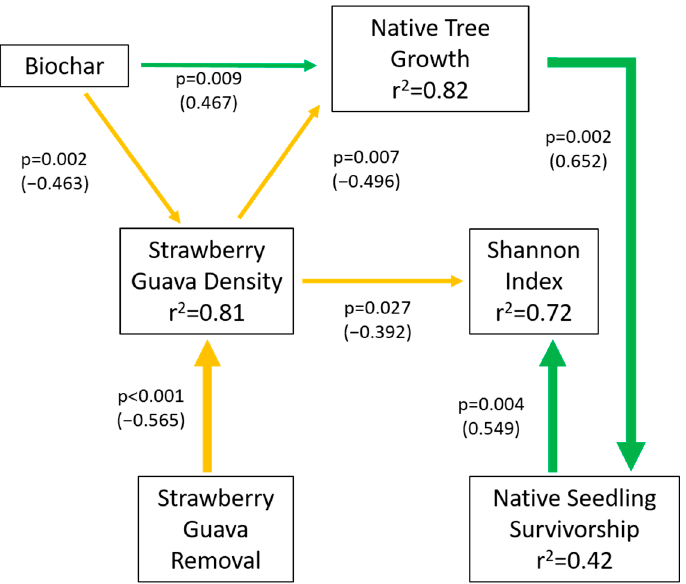
Figure 6. Structural equation model illustrating drivers of native tree growth, native seedling survivorship, strawberry guava density, and tree diversity in the experiment. Arrow thickness is proportional to path coefficients. Values listed by arrows are standardized path coefficients with p -values. An r 2 value is shown in the box of each response variable.